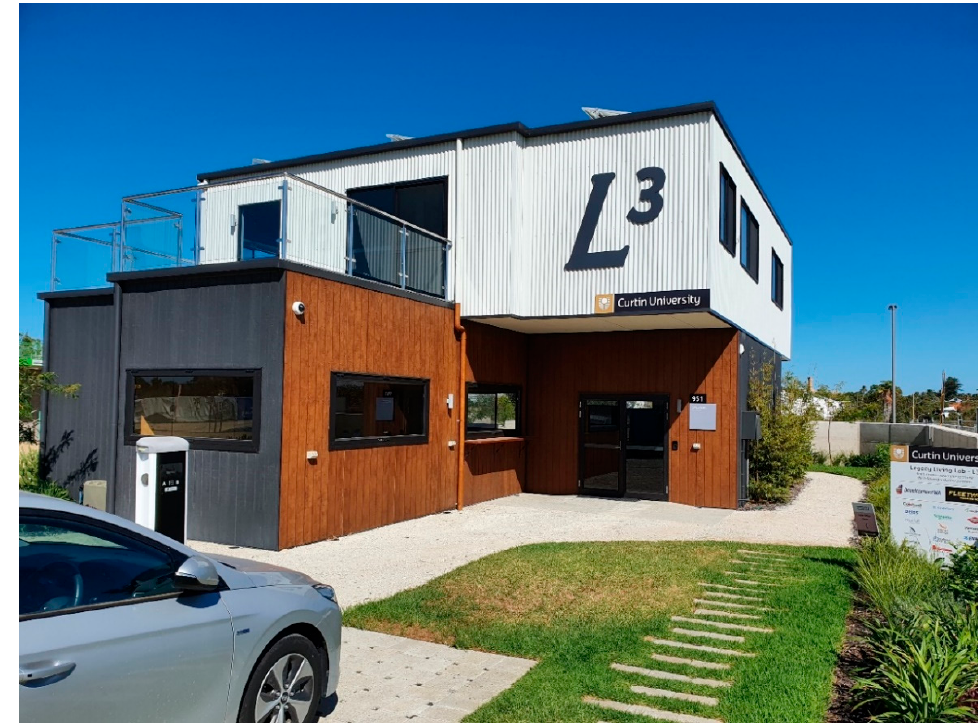
Figure 2. The case study selected for this research, the Legacy Living Lab.